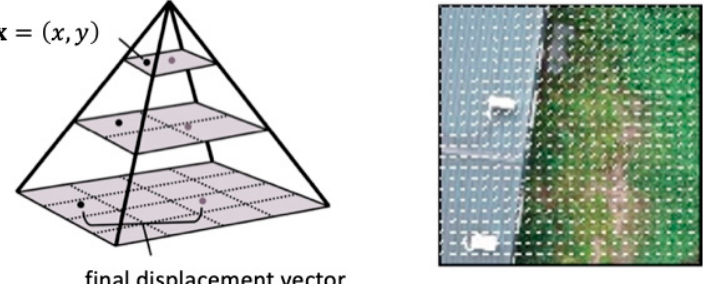
Figure 3. An image pyramid with three levels of pixel resolution. The top level has the lowest pixel resolution while the bottom level has the highest pixel resolution. The iterative Gunnar–Farnebäck algorithm is used to estimate the optical flow from top to bottom. An example of the estimated flow field is shown on the right.